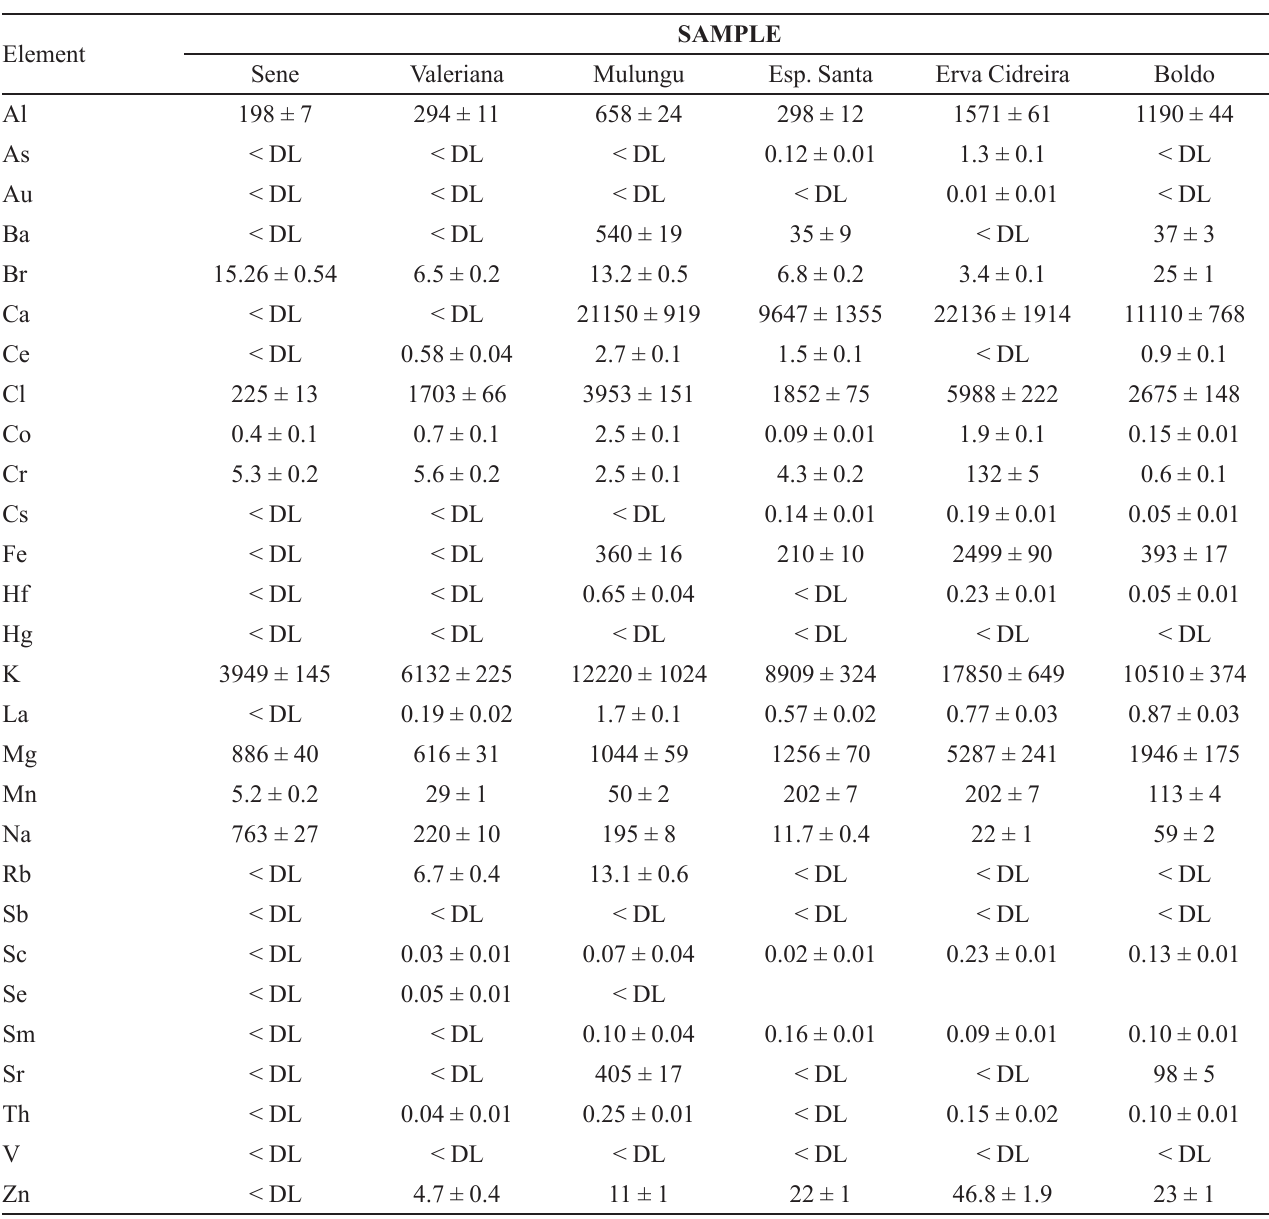
TABLE IV - Elemental concentration (mg kg -1 ) of the samples: Sene, Valeriana (DE), Mulungu (P), Boldo , Erva Cidreira and Espinheira Santa